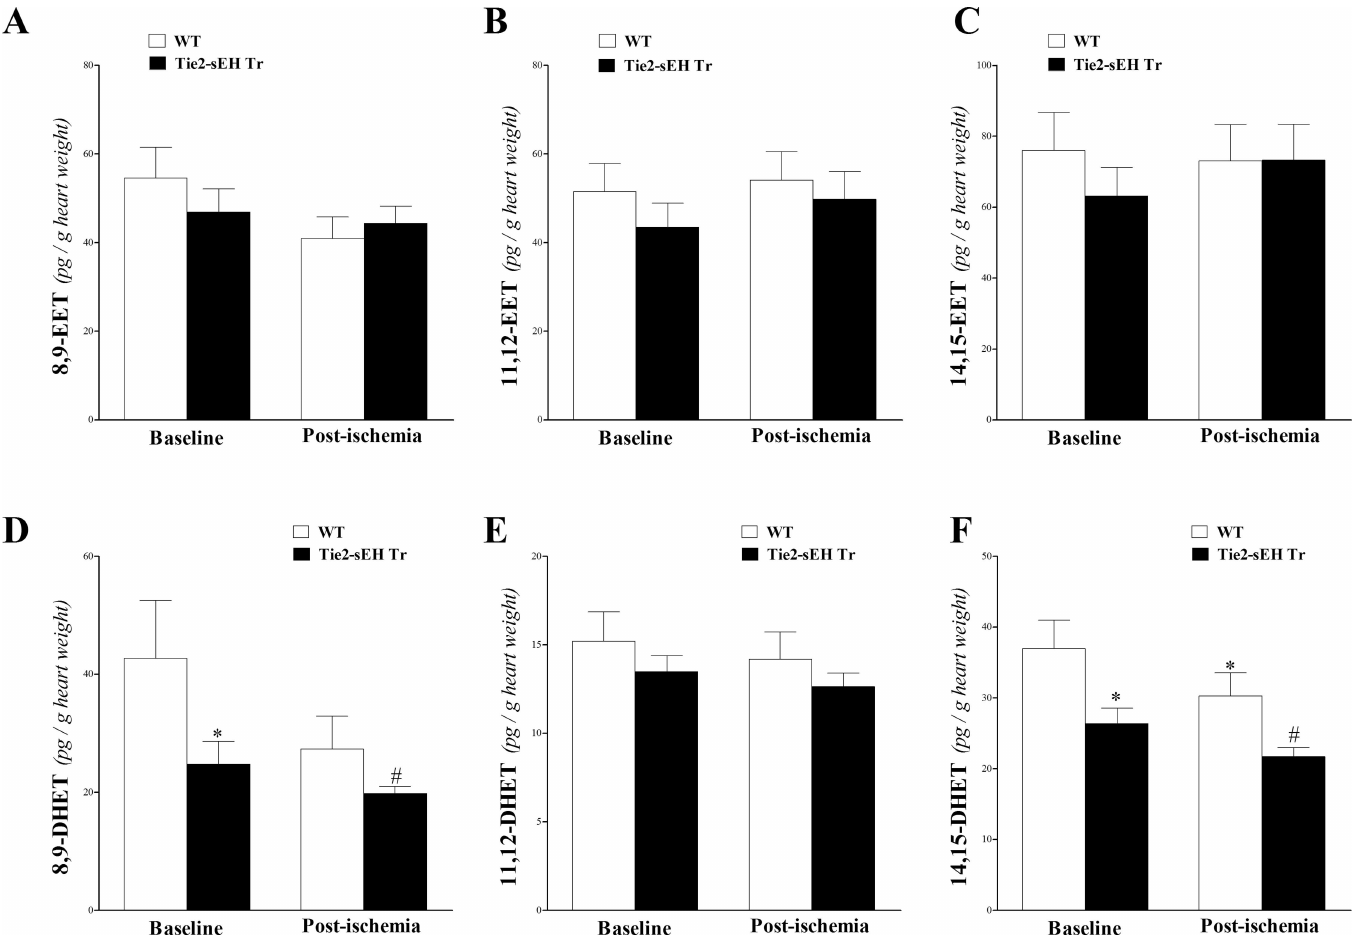
Fig 3. LC–MS/MS analysis for EETs (8, 9–, 11, 12–, and 14, 15–) and DHETs (8, 9–, 11, 12–, and 14, 15–) levels in WT and Tie2-sEH Tr mouse heart perfusates at baseline and post-ischemia. 8,9-EET (A), 11,12-EET (B), and 14,15-EET (C) were not significantly different betweenWT and Tie2-sEH Tr mice. Also, the levels of EETs were not affected in responseto ischemiain either mouse strain ( P > 0.05). 8,9-DHET (D), and 14,15-DHET(F) were decreased in Tie2-sEH Tr comparedto WT mice ( P < 0.05), whereas11,12-DHET(E) was not significantly different betweenthe two groups( P > 0.05). Also, 14,15-DHET(F) was decreased in responseto ischemiain Tie2-sEH Tr ( P < 0.05). * P < 0.05 versus baselineWT. # P < 0.05 versus WT post-ischemia. n = 12 WT and 14 Tie2-sEH